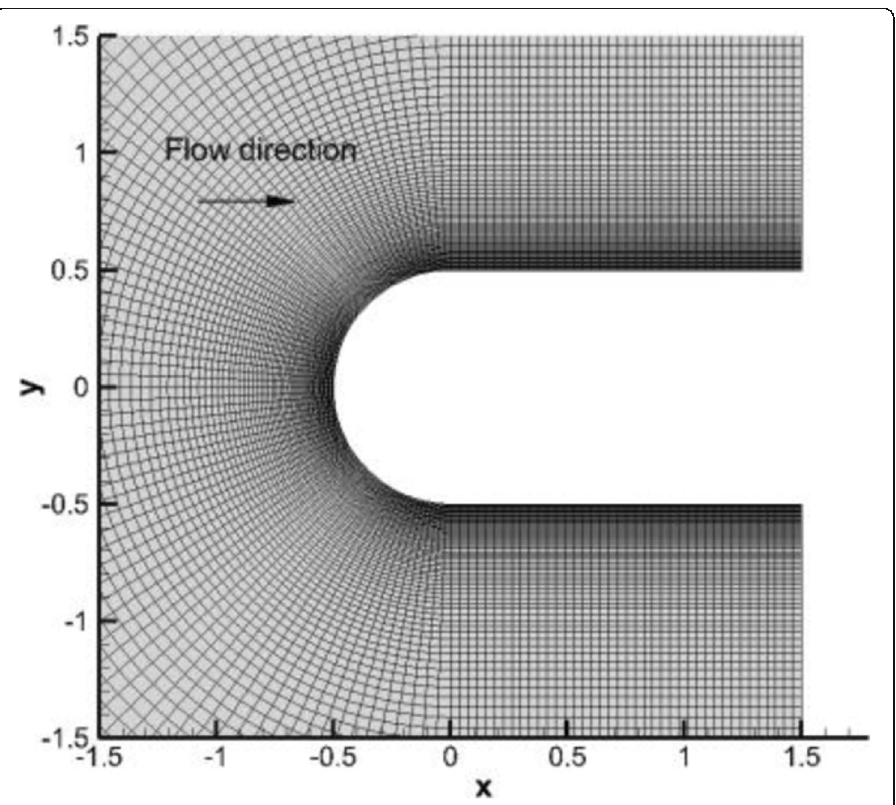
Fig. 7 Meshes and configuration for